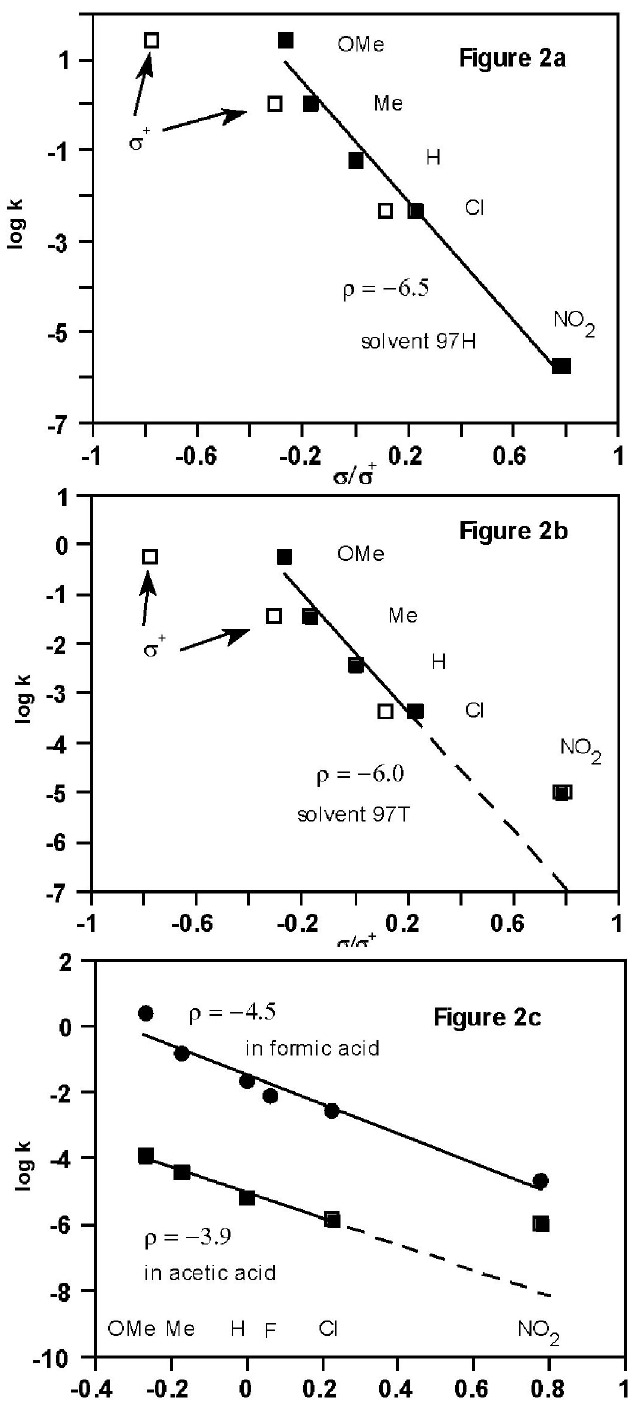
Figure 2. Plots of logarithms of rate constants for solvolyses in various solvents vs . σ and σ + (substituent parameters from reference [19]): ( a ) solvent 97% hexafluoroisopropanol-water (97H), ρ = −6.5 ± 0.5, data from Table 1; ( b ) solvent 97% trifluoroethanol-water (97T), ρ = −6.0 ± 1.0, data from reference 1; ( c ) solvents acetic (ρ = −3.9 ± 0.3) and formic acids (ρ = −4.5 ± 0.5), data from Table